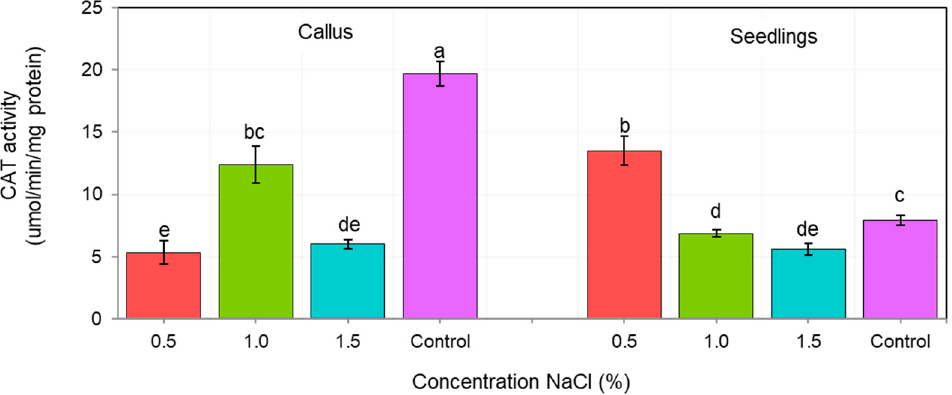
Figure 4. Changes in catalase activity (CAT) in callus and seedlings of F. excelsior L. Other letters— there are statistically significant differences.